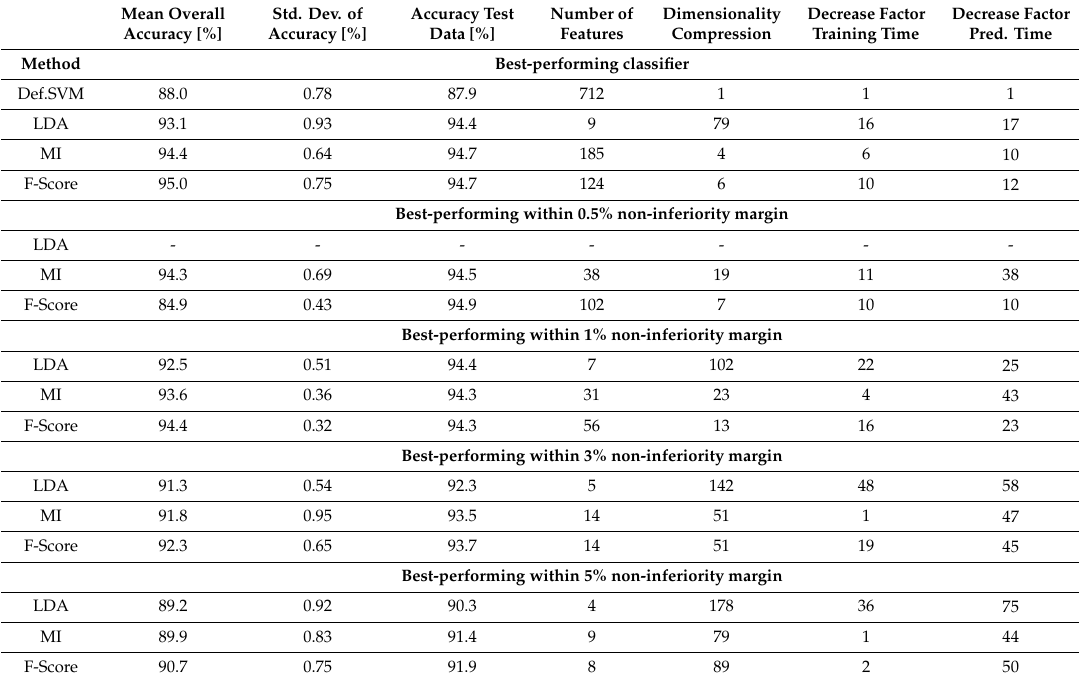
Table 6. Overview of the best-performing classifiers (Stockholm)